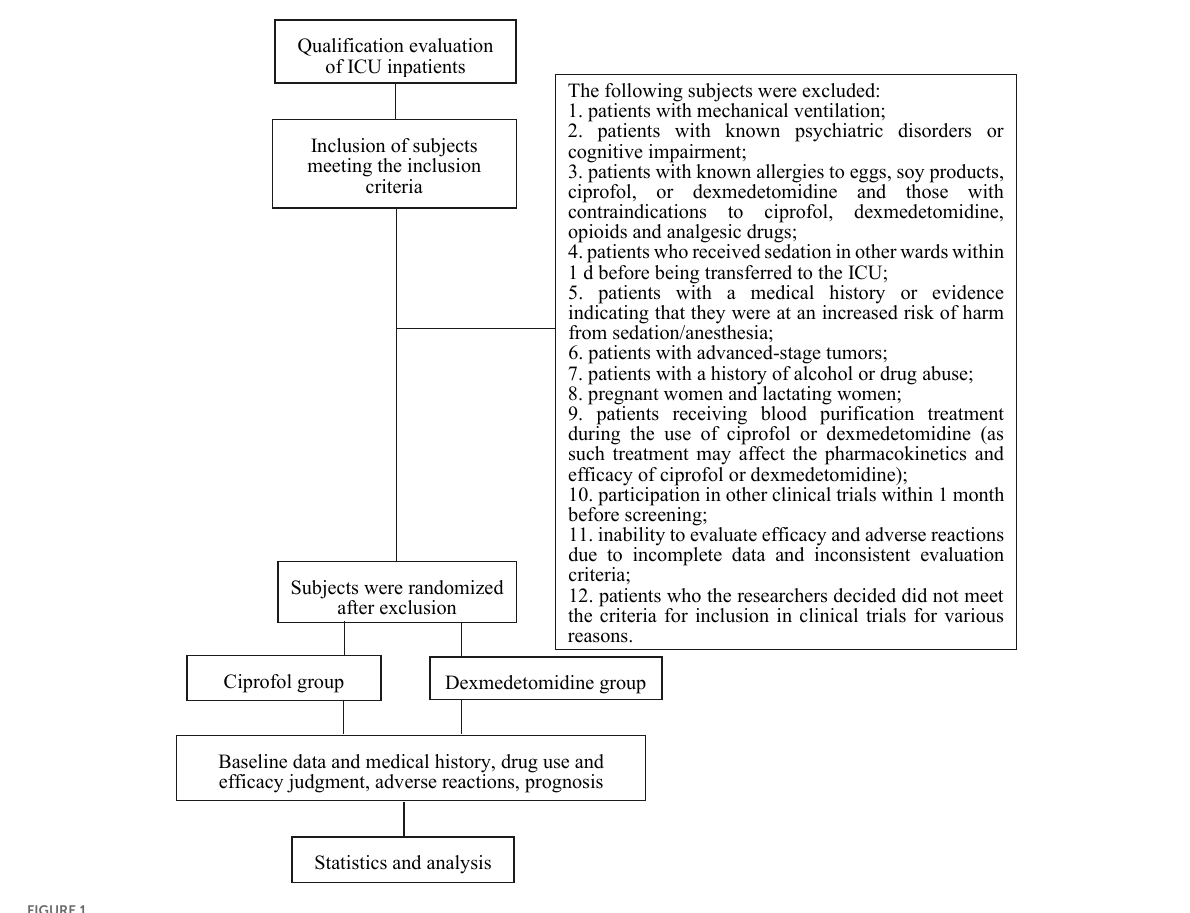
FIGURE1 Flow chart: screening, recruitment, and grouping of patients.